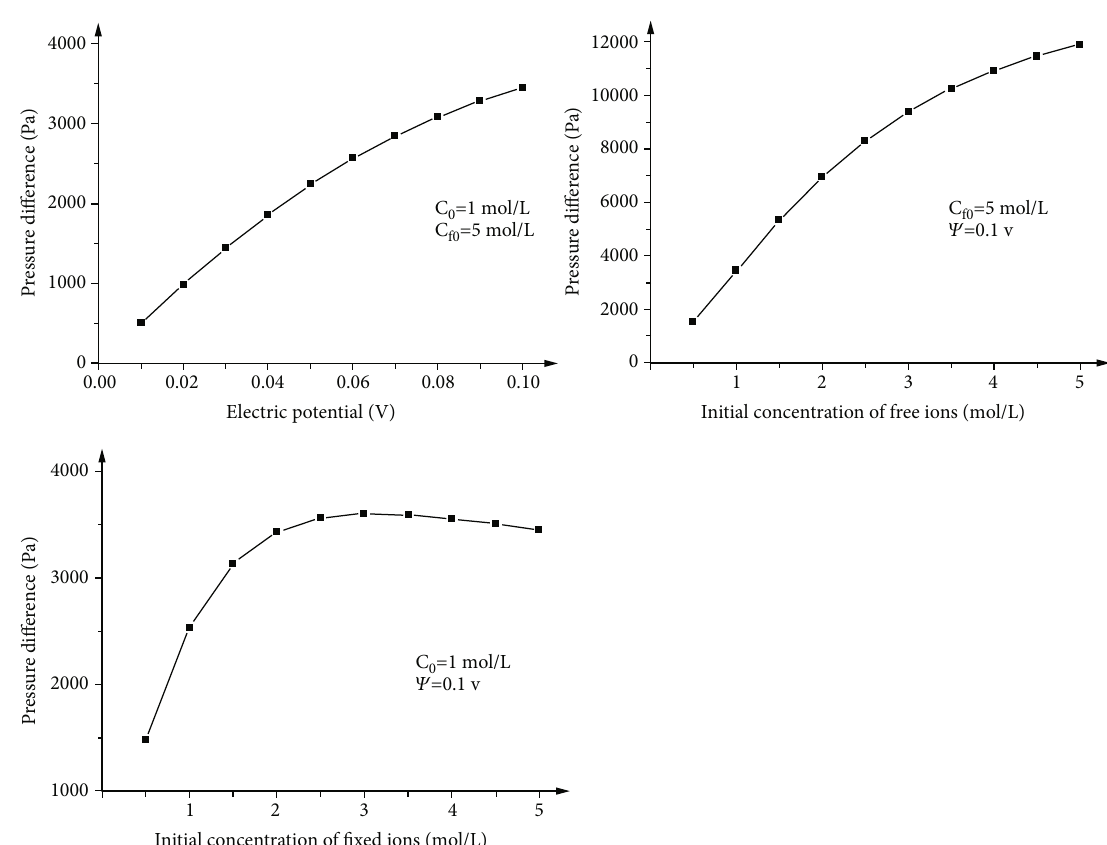
Figure 4: The e ff ects of electric potential, free ion concentration, and fi xed ion concentration on the pressure di ff erence.